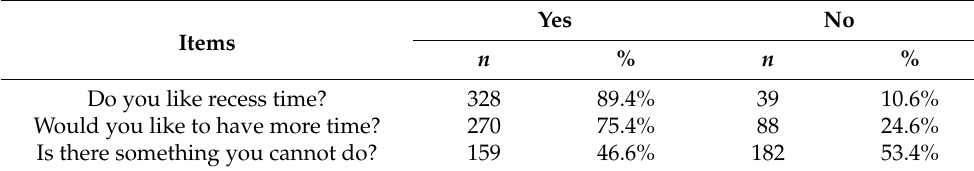
Table 1. Children’s play experiences in primary school during the